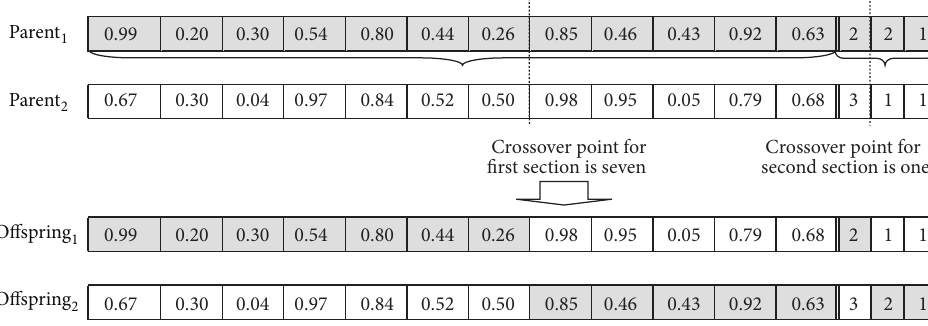
Figure 3: Crossover operation: two parents mate in order to produce two offsprings.